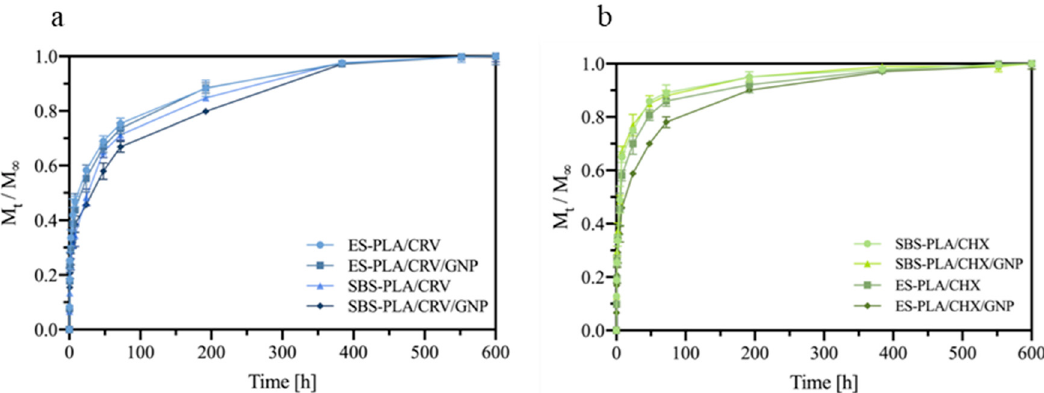
Figure 10. Release kinetics of CRV ( a ) and CHX ( b ) from membranes in deionized water at 37 °C expressed as M t /M ∞ . Each measurement was performed in triplicate.